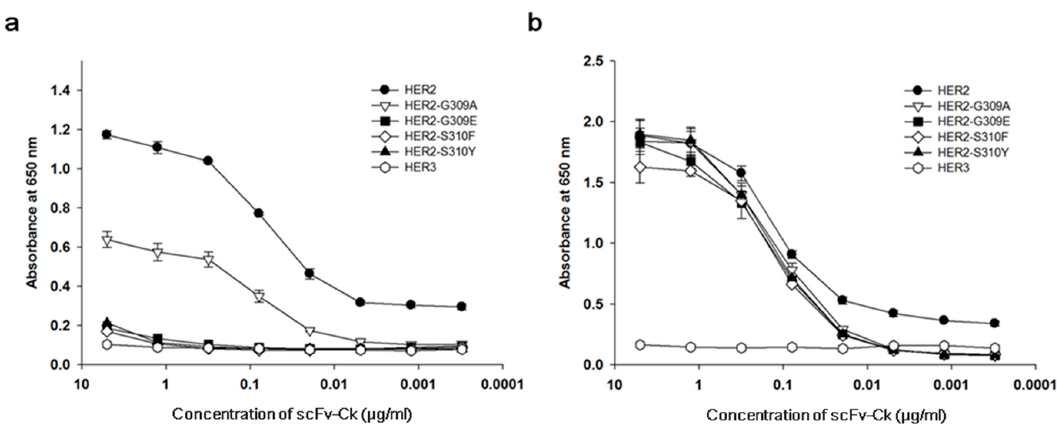
Figure 1. Reactivity of G309 and S310 HER2 mutants to pertuzumab and trastuzumab. Recombinant G309 and S310 mutant, wild-type HER2 or wild-type HER3 human Fc fusion protein was coated onto the wells of microtiter plates. The plate was blocked and subjected to incubation with ( a ) recombinant pertuzumab scFv-human C κ fusion protein, or ( b ) trastuzumab scFv-human C κ fusion protein at varying concentrations. Wild-type HER3 human Fc fusion protein was used as a negative control, because it does not bind to either antibody. The amount of bound antibody was determined using HRP-conjugated human C κ light chain antibody and 3,3 ′ ,5,5 ′ -tetramethyl benzidine (TMB) substrate solution.